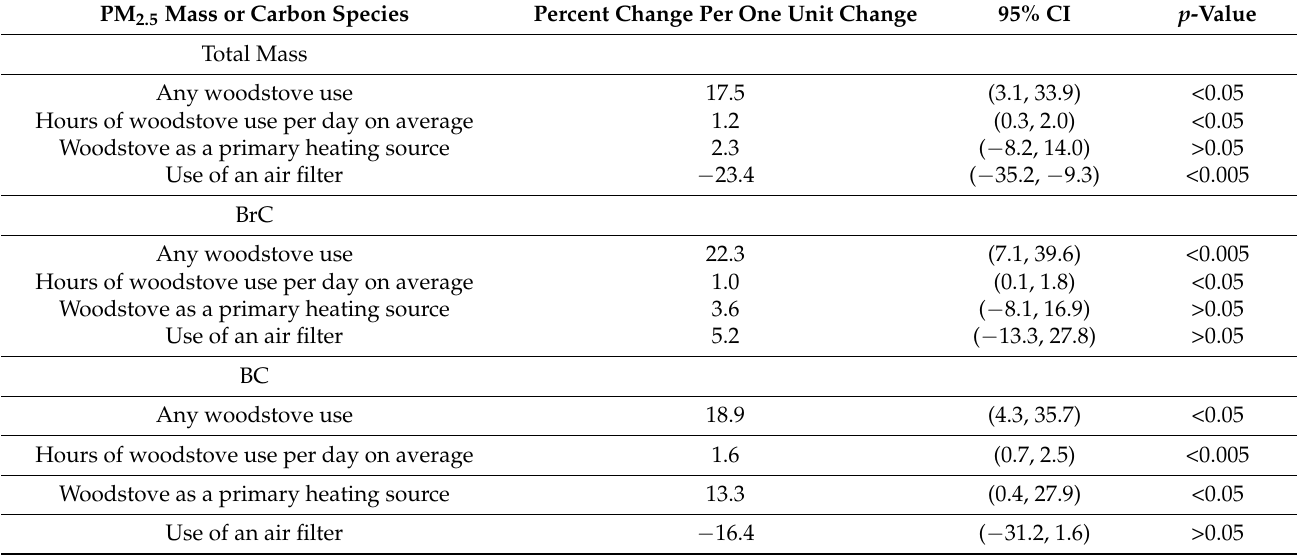
Table 1. Percentage change in PM2.5, BC, and BrC levels for each type of exposure for children without ETS